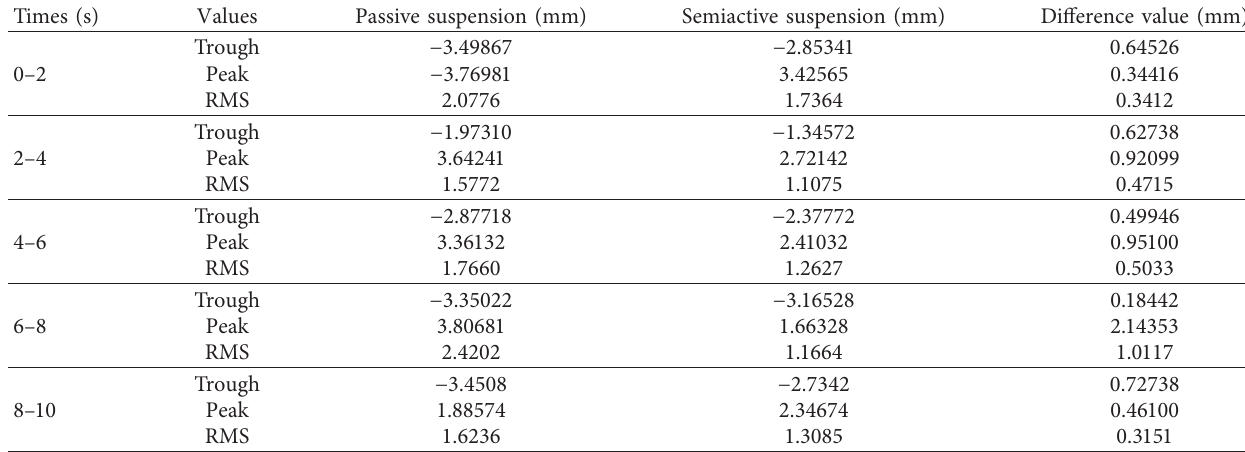
Table 6: Comparison of peak and RMS values of displacement curve.